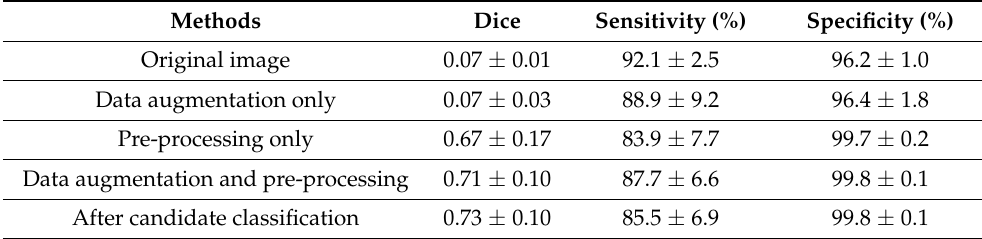
Table 1. Performance metrics of pixel-wise microvessel segmentation over five folds, including the Dice coefficient, sensitivity, and specificity. The segmentation results were greatly improved using data augmentation and pre-processing. The candidate classification step removed some false positive segmentation spots, improving the pixel segmentation results.